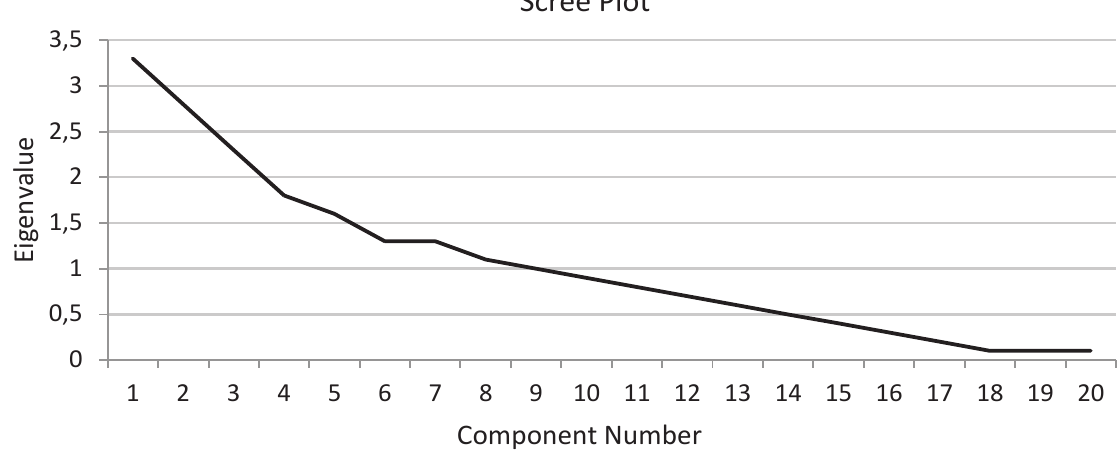
Figure 2. Scree plot for the statements related to heritage tourism site attributes in Himachal Table 3. KMO and Bartlett’s Test for the